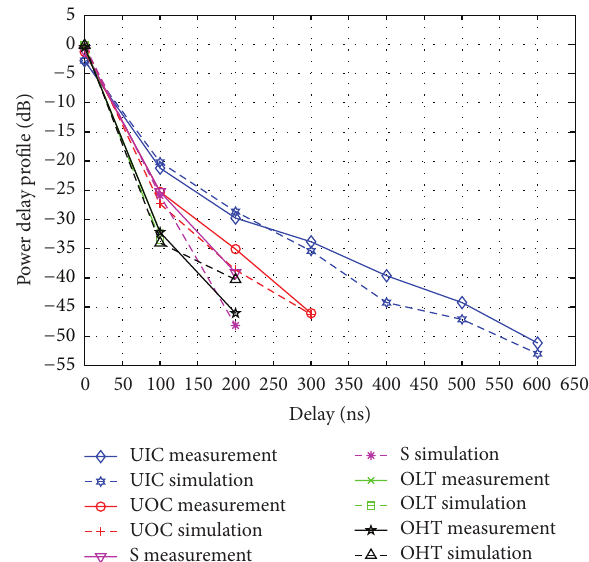
Figure 4: Power delay profile of the TDL based non-WSSUS V2V channel model in OFDM system (five scenarios: UIC, UOC, Small City, OLT, and OHT).